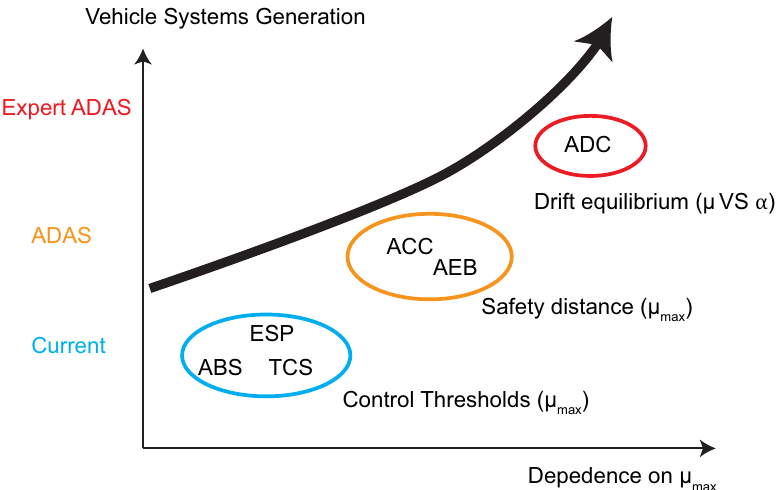
Figure 9. Impact of the road friction potential estimation µ max on different generations of vehicle systems. Current vehicle systems (e.g., ABS) are less dependent on the a priori road friction information than current (e.g., AEB) or expert ADAS (e.g., ADC).